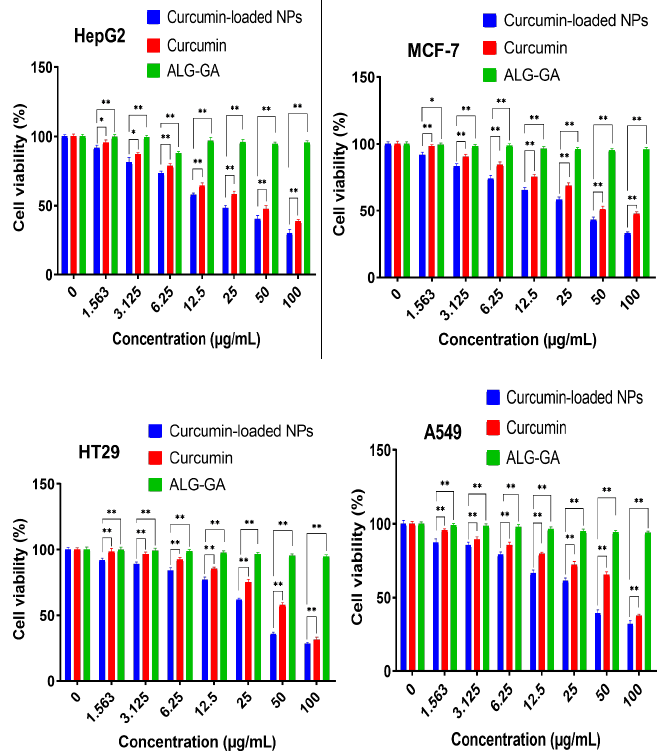
Figure 10. Cytotoxicity activity of Curcumin and curcumin-loaded NPs at different concentrations exposed to cancer cell lines (MCF7, HepG2, A549, and HT29) after 72 h. The values were the mean ± SD from three independent experiments expressed as percent control. Error bar are * p < 0.05, ** p < 0.01. Table 2. The IC 50 values for HepG2, MCF7, A549 and HT29 cells generated from MTT assay following exposure to Cur and Cur/ALG-GANPs for 24, 48 and 72h. Cell line Duration ) h (